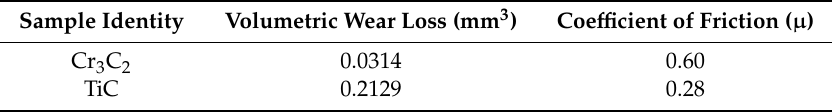
Table 2. Sliding wear results of the investigated